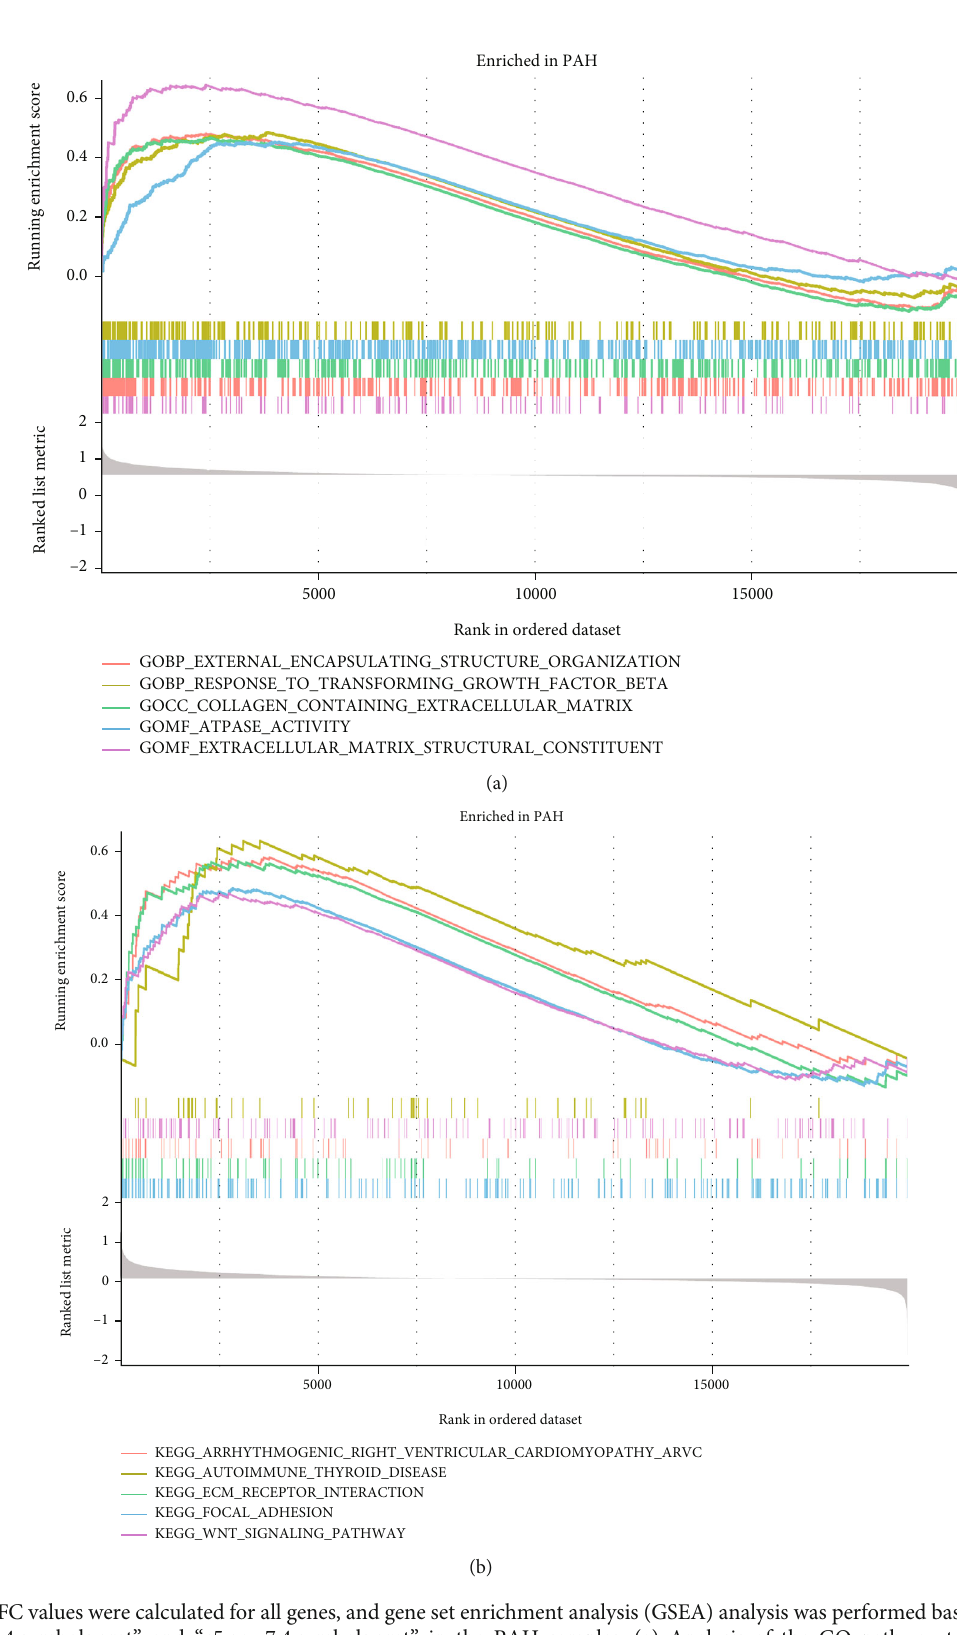
Figure 6: LogFC values were calculated for all genes, and gene set enrichment analysis (GSEA) analysis was performed based on logFC using “ c2.cp.kegg.v7.4.symbols.gmt ” and “ c5.go.v7.4.symbols.gmt ” in the PAH samples. (a) Analysis of the GO pathway terms for all genes enriched in the PAH samples using GSEA. (b) Analysis of the KEGG pathway terms for all genes enriched in the PAH samples using GSEA. PAH: pulmonary arterial